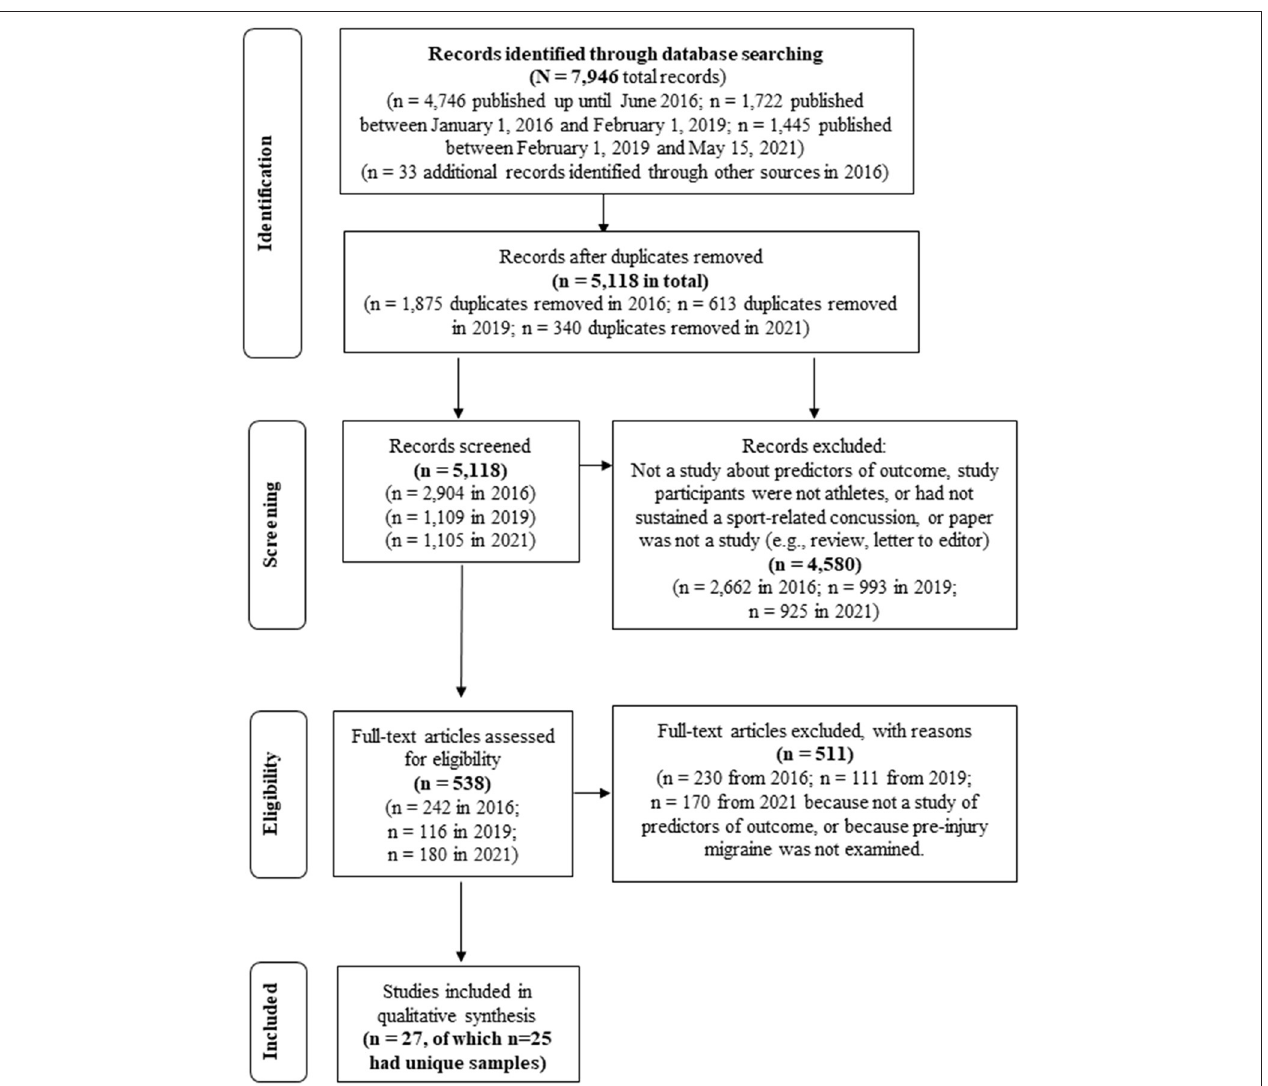
FIGURE 1 | Systematic Literature Search